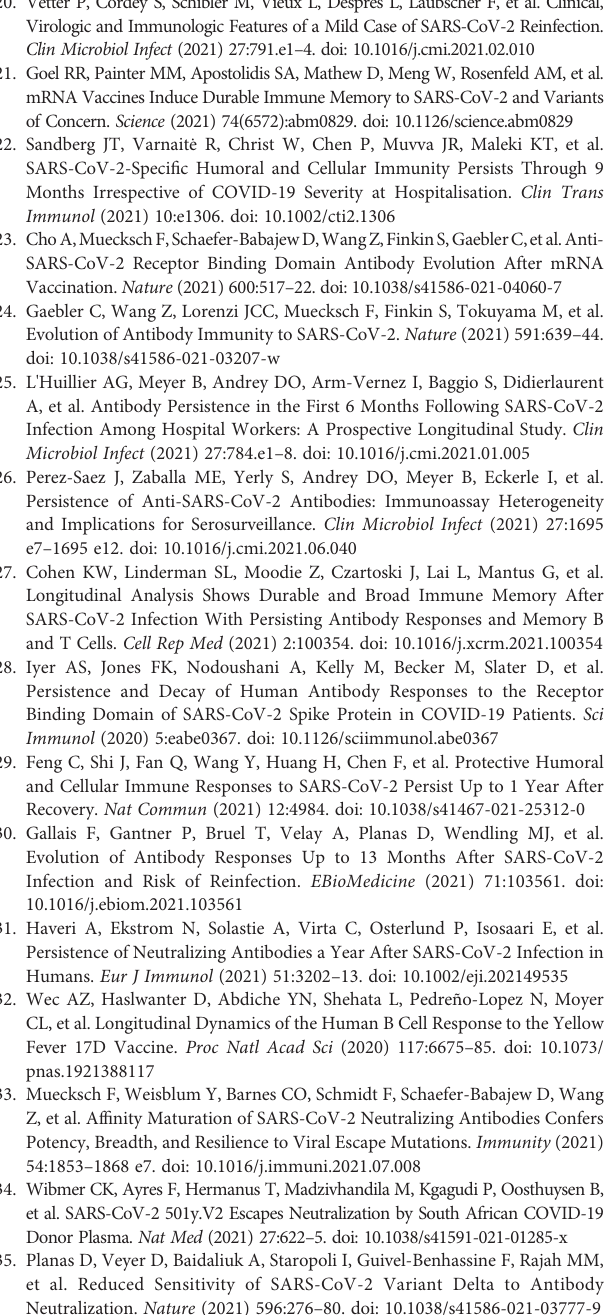
Supplementary Figure 3 | Antibody responses to VOC during mild COVID-19. (A) Fold change of VOCs compared to the WT strain of SARS-CoV-2 at different time points post infection. Mean +/- SD is shown in black. (B) Comparison of